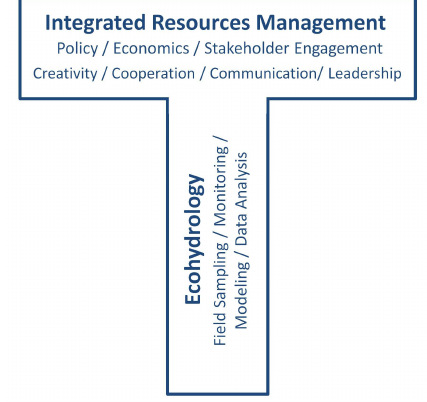
Fig. 2. T-shaped competencies of an ecohydrologist. The vertical bar reflects the depth of specialized scientific knowledge, while the horizontal bar reflects cross-cutting knowledge of related dis- ciplines as well as personal competencies enabling more effective participation in collaborative